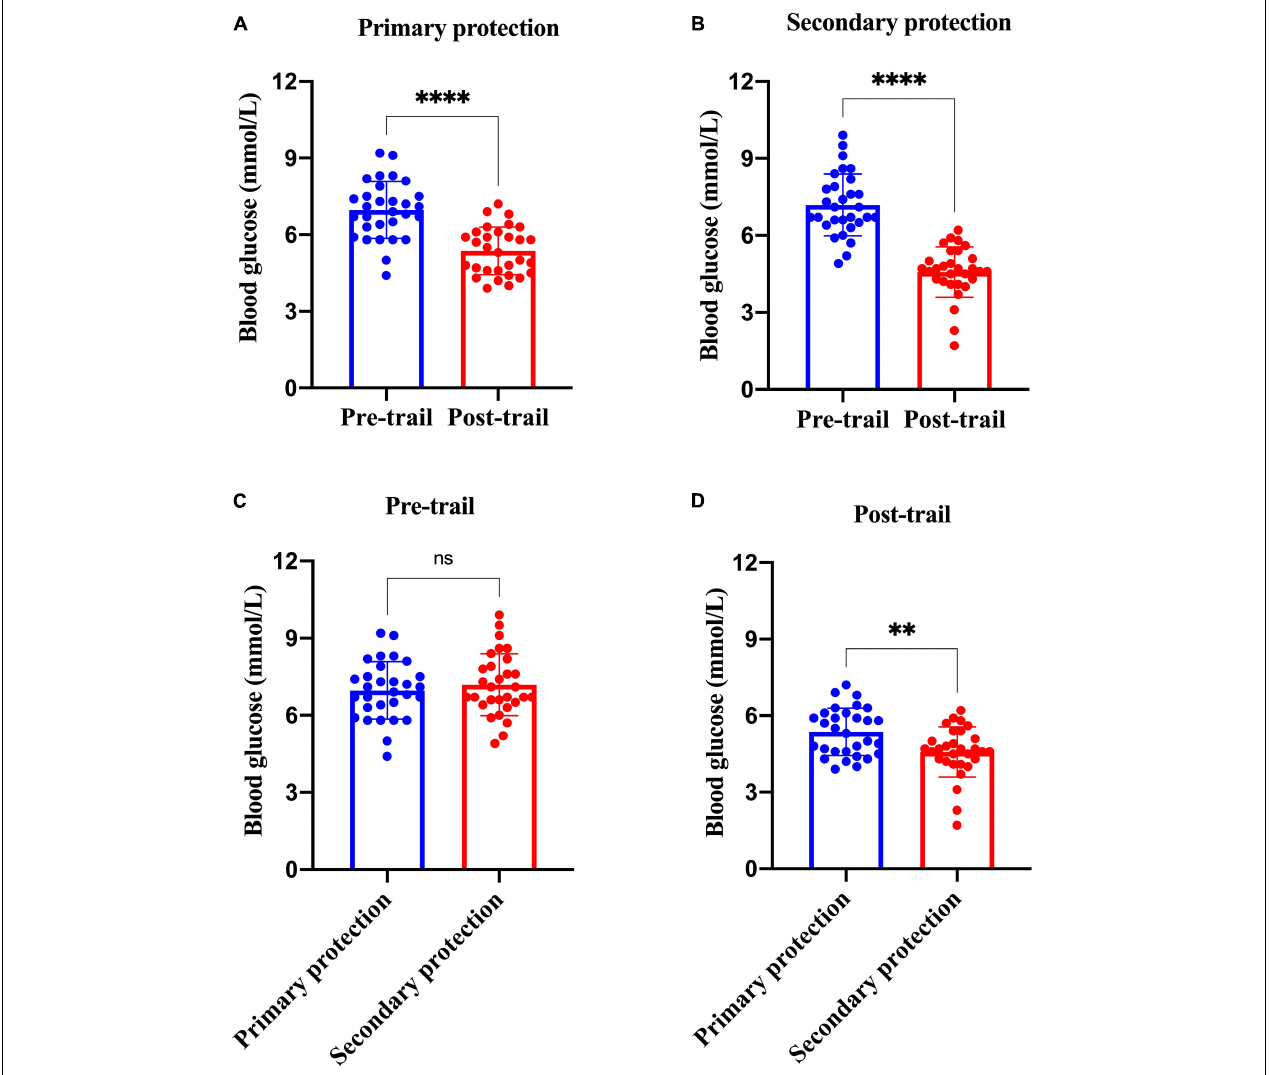
FIGURE 7 | Analysis of blood glucose changes of participants with primary and secondary PPE. (A) The blood glucose differences of the research participants before and after the trial under the primary protection; (B) the blood glucose differences of the research participants before and after the trial under the secondary protection; (C) the blood glucose differences of under the primary protection vs. secondary protection before the trial; (D) the blood glucose differences of under the primary protection vs. secondary protection after the trial. ∗∗ p < 0.01; ∗∗∗∗ p < 0.0001; and ns, p > 0.05. PPE, personal protective equipment.